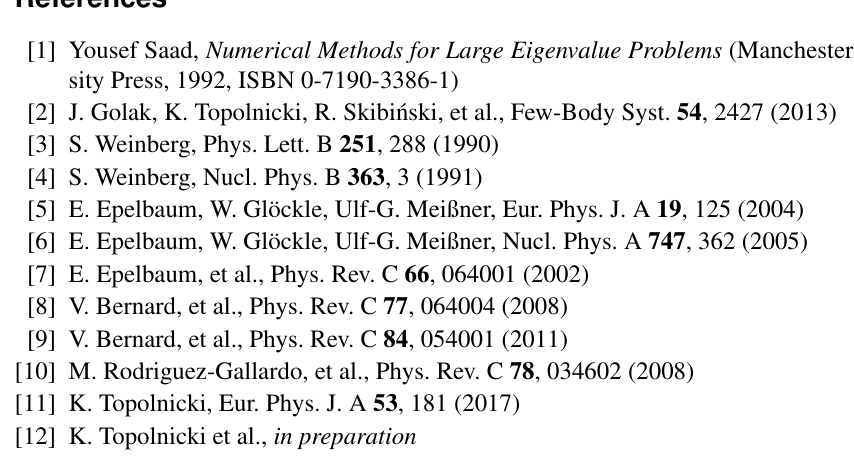
, t = 0; T = 1 , t = 1 and T = 3 , t = 1 2 2 2